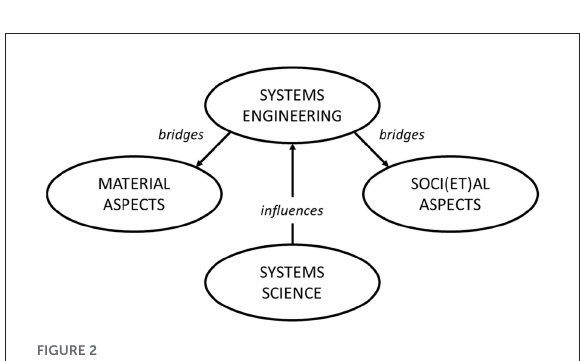
FIGURE2 The theoretical foundation of the